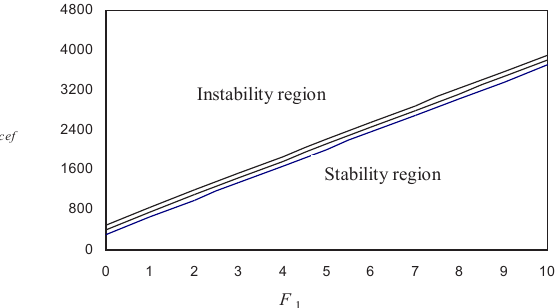
Fig. 2. The variation in the critical thermal Rayleigh number R 1 with the couple-stress parameter F